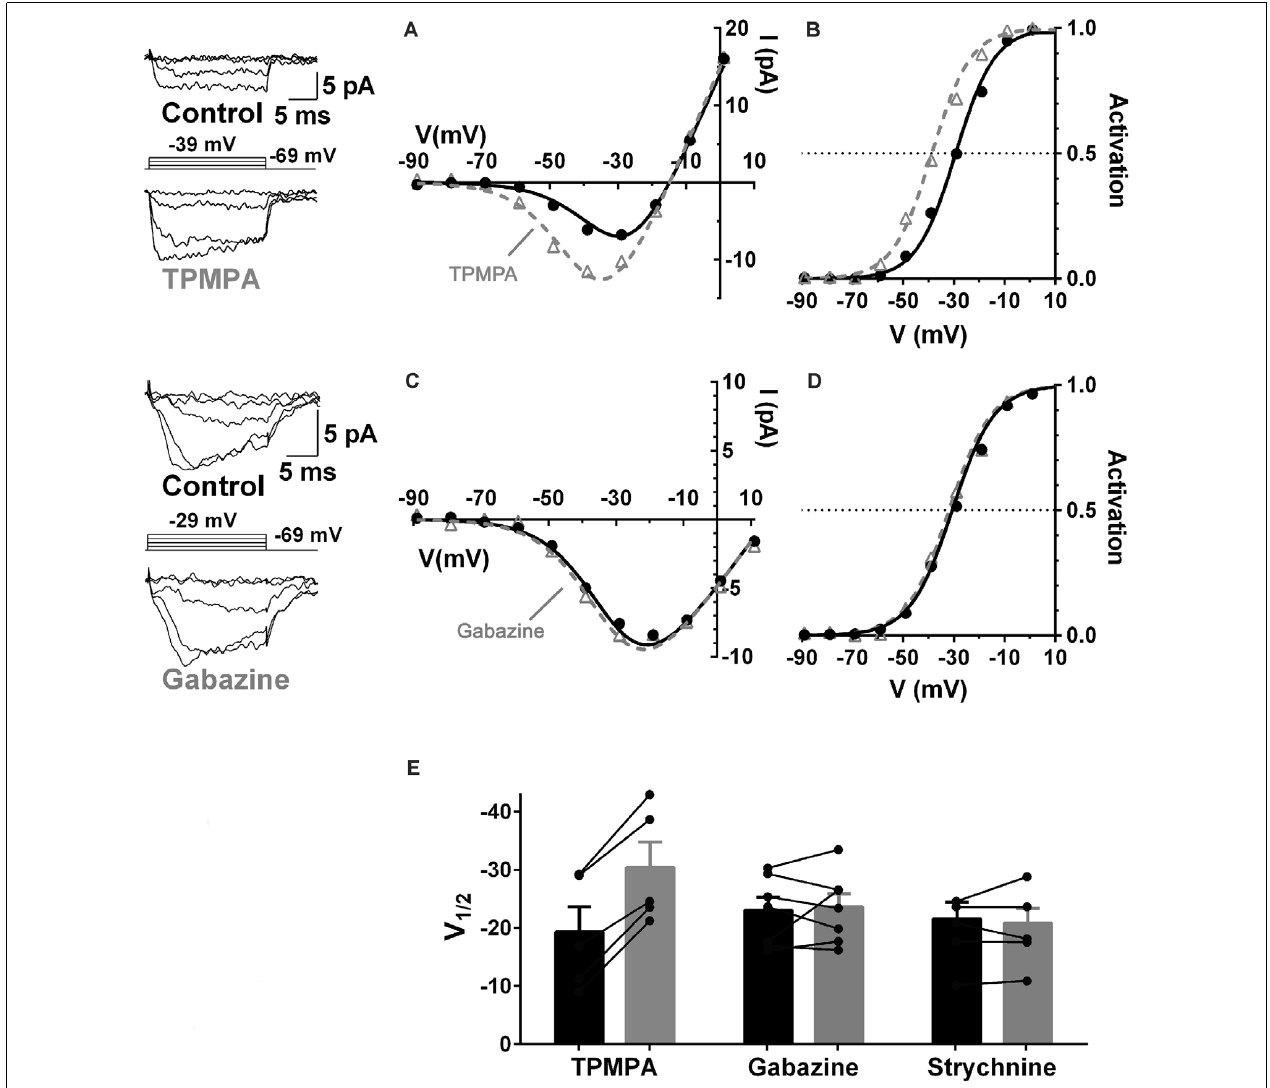
FIGURE 5 | GABA receptors containing ρ -subunits mediate the modulation of cone Ca V currents. Effects of GABAR blockers on Ca channel currents in cones in guinea pig retinal slices. (A,B) The ρ -subunit-containing GABAR antagonist TPMPA (50 µ M) shifted Ca V activation in guinea pig cones to more negative voltages, in this case by 10 mV. (C,D) The GABA A R antagonist gabazine (10 µ M) did not affect Ca V activation. (E) Summary of the effects of TPMPA, gabazine, and the GlyR antagonist strychnine (100 µ M) on Ca V channel activation (5–7 cones). In each pair the filled bar (on left) is control and the gray bar (on right) shows the change in the presence of the blocker. Figure modified from Grove et al.